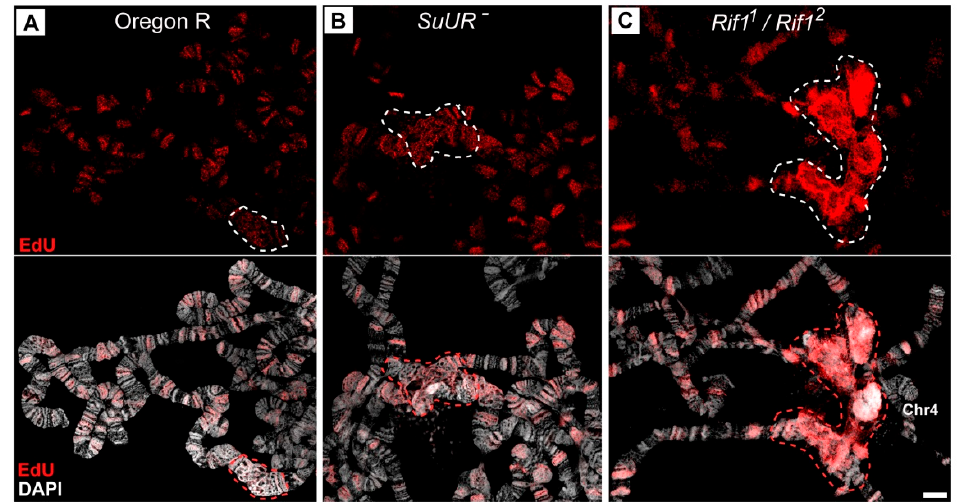
Figure 9. Analysis of the replication patterns corresponding to late discrete labeling using super-resolution 3D-SIM of the polytene chromosomes of wild-type larvae and the SuUR and Rif1 mutants. Visual fields inside salivary gland nuclei from the Oregon R ( A ), SuUR ES ( B ) and Rif1 1 / Rif2 2 ( C ) larvae at the late discrete labeling replication stage. Dashed lines indicate the chromocenters. Scale bar 5 µ m.